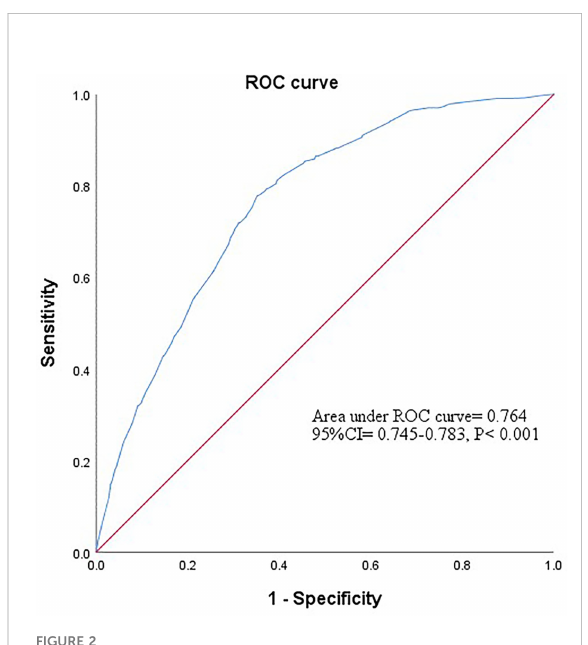
FIGURE 2 The ROC curve of combined factor model based on the data of gender, glucose, body mass index, triglycerides and favorable alleles. Based on the results of stepwise regression analysis, a combined factor model was constructed for the fi ve variables of gender, glucose, body mass index, triglycerides and favorable alleles to assess the risk of NAFLD. The AUROC for this combined model was 0.764 (95% CI = 0.745-0.783, P